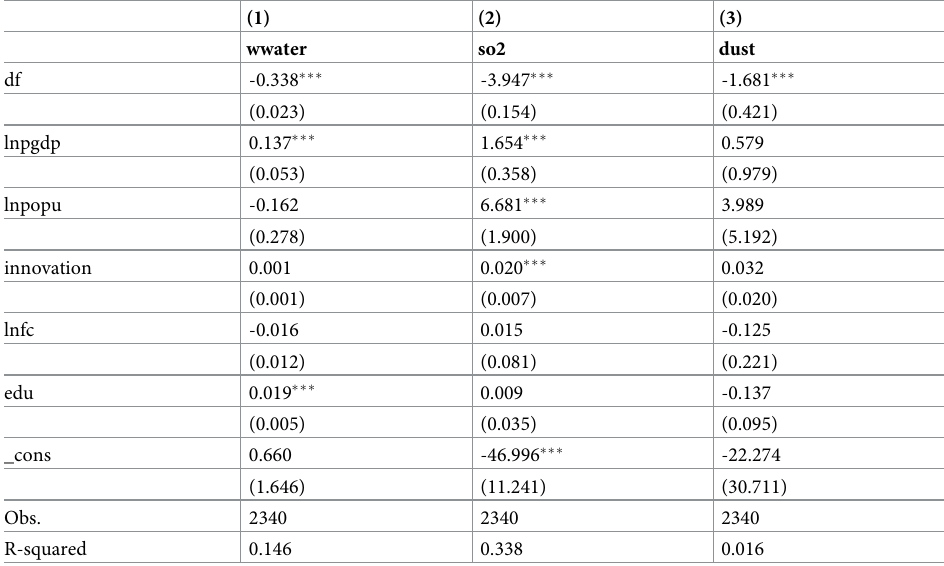
Table 5. Regression results of fixed effects for different